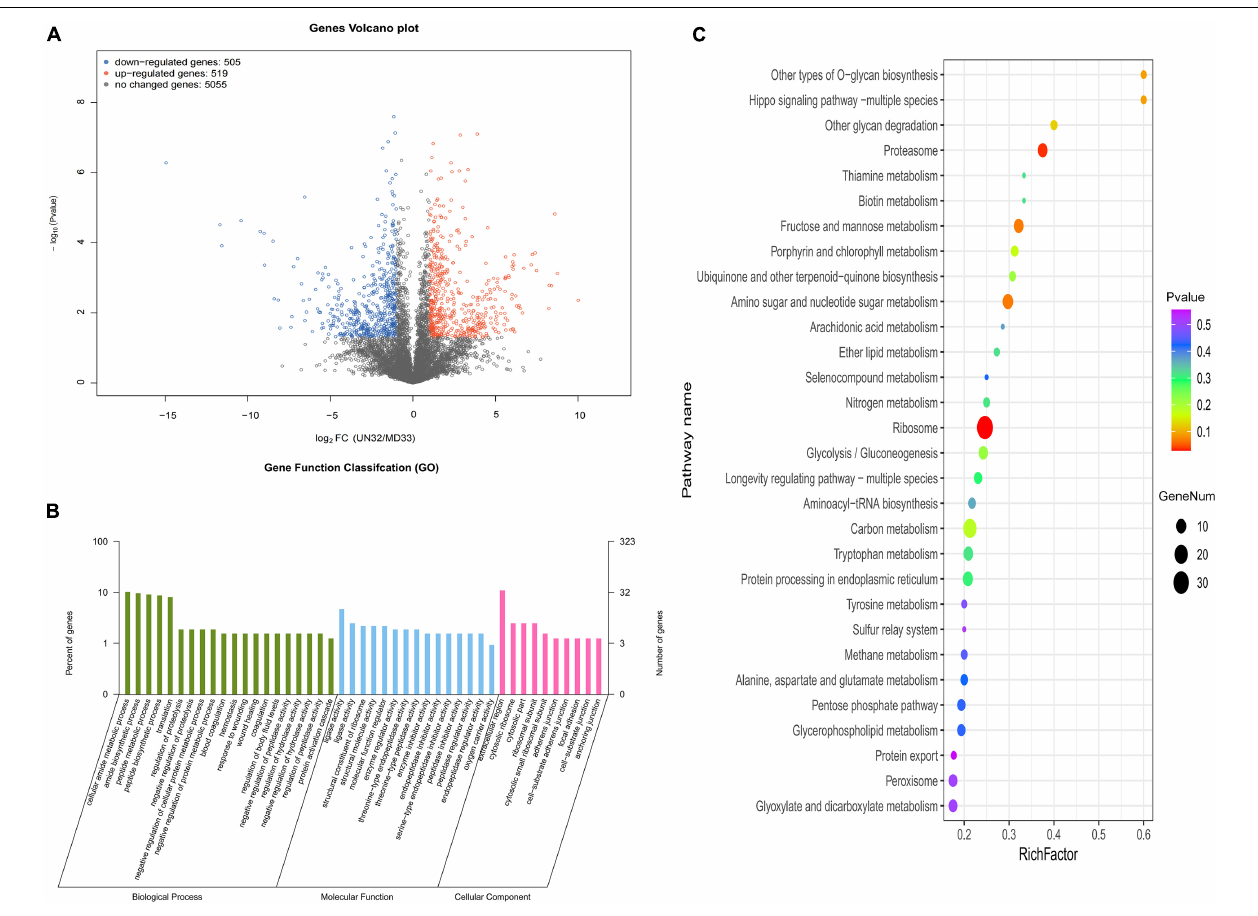
FIGURE 2 | Transcriptional variation between strain MD33 and UN32. (A) Significance analysis of all DEGs between the strain MD33 and UN32 by a volcano plot. (B) GO enrichment analysis. (C) KEGG enrichment